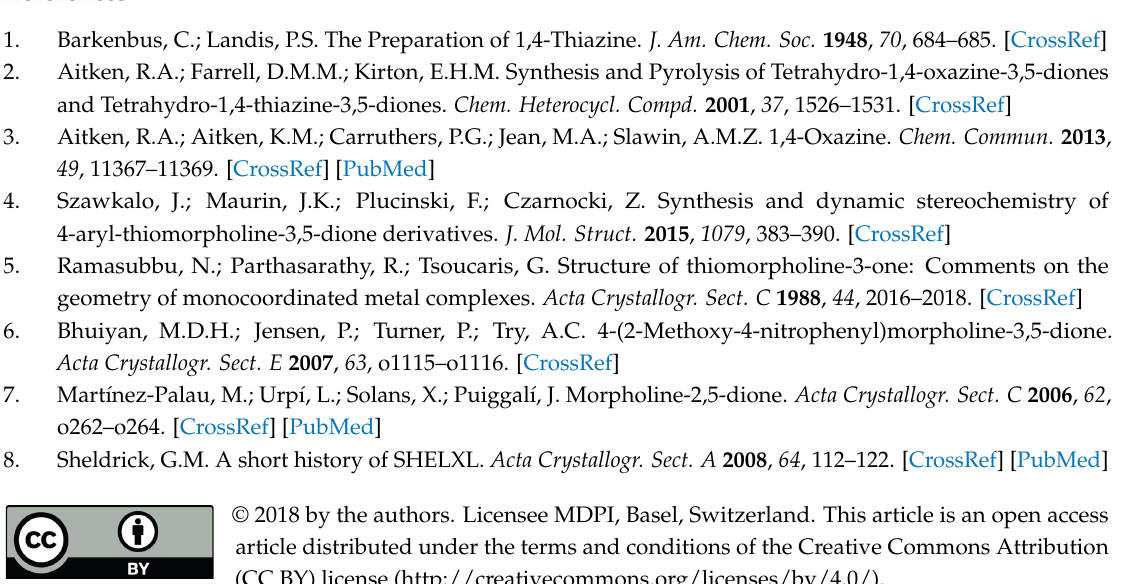
Supplementary Materials: The following are available online, Figure S1: 300 MHz 1 H-NMR spectrum of 1 in CDCl 3 , Figure S2: 75 MHz 13 C-NMR spectrum of 1 in CDCl 3